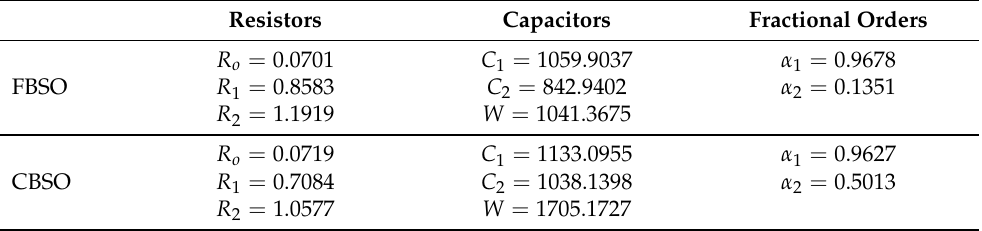
Table 2. The results of parameter identification with FBSO and